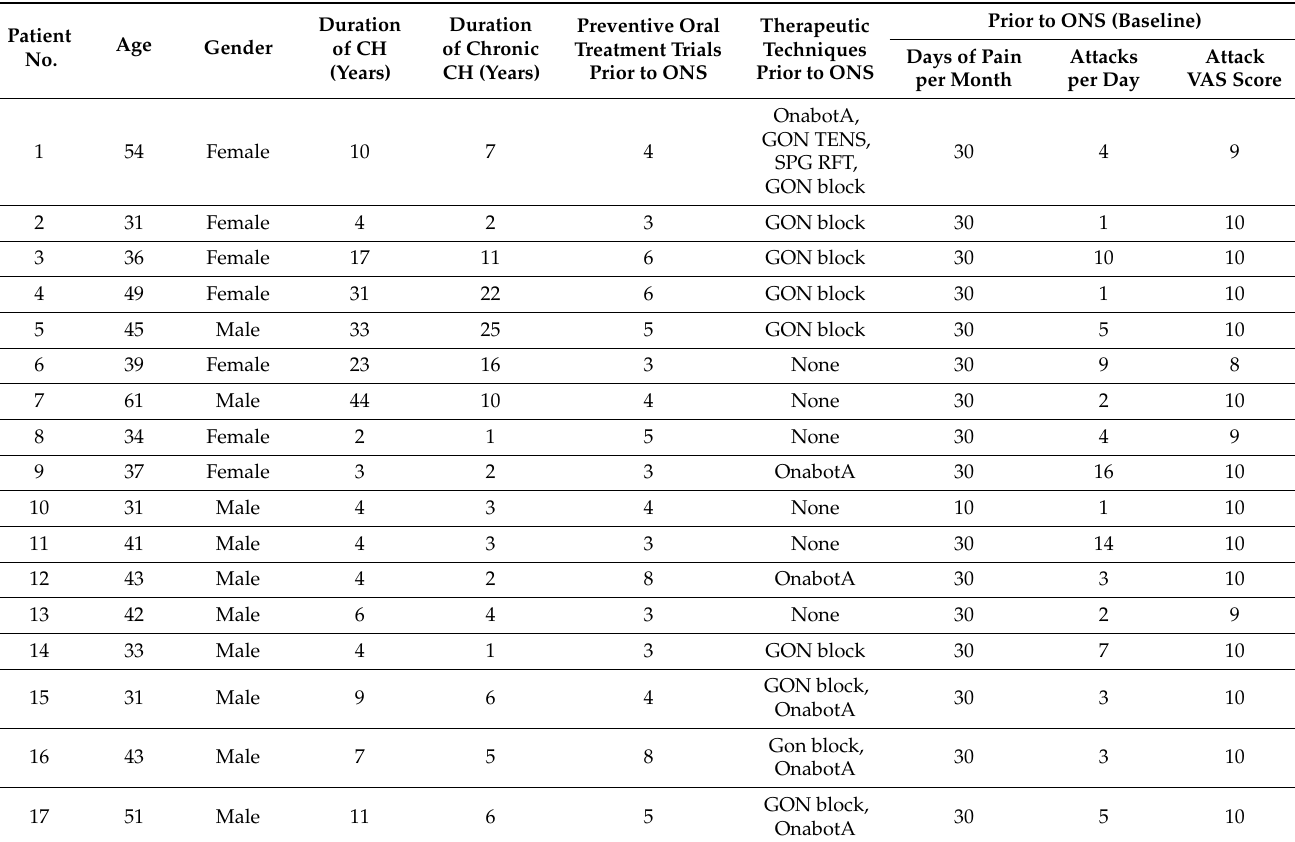
Table 2. Epidemiological and nosological characteristics of cluster headache patients treated with occipital nerve stimulator. Patient